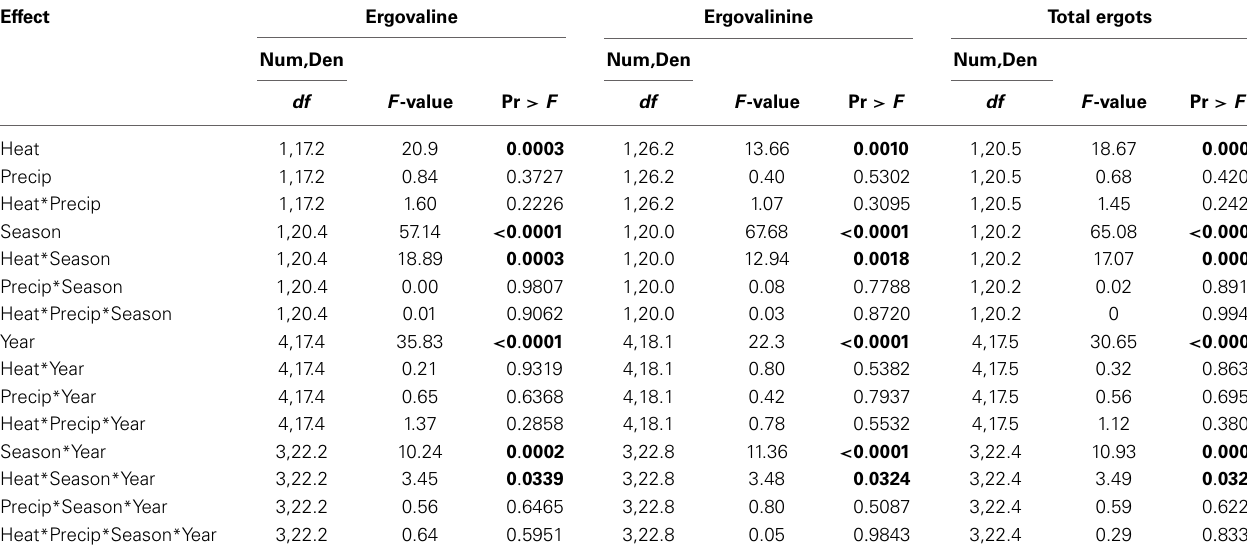
Table 4 | Statistical results of the effects of the climate treatments ( + heat and + precip), season, year, and their interactions on the concentrations of ergovaline, ergovalinine, and their sum (total ergots measured in this study) in endophyte infected tall fescue tillers.